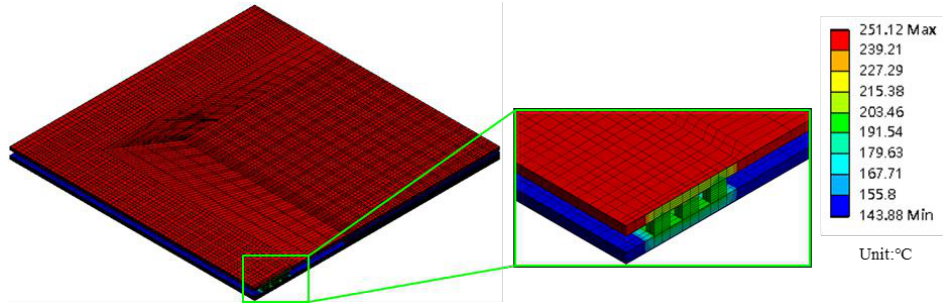
Figure 11. Temperature distribution of the assembly during interposer bonding